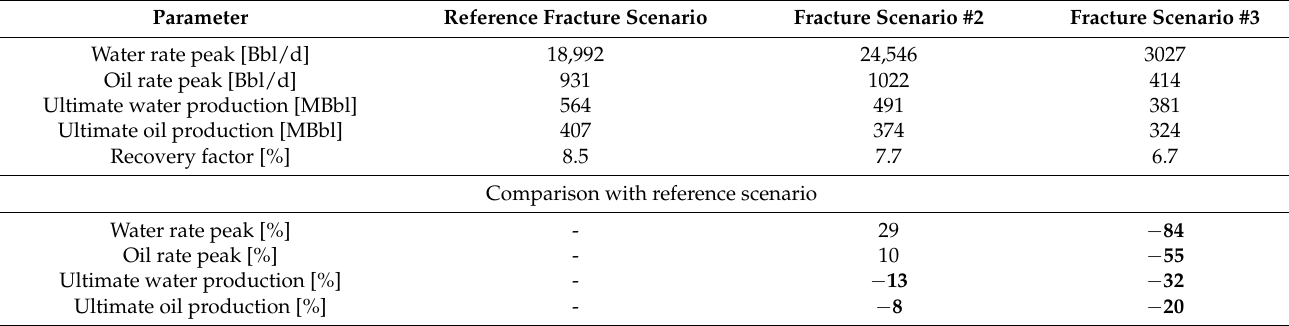
Table 4. Simulation case 2: production comparison after 15 years between fracture scenarios #2 and #3, and the reference fracture scenario #1. The reference scenario comprises 3 vertical hydraulic fractures (HF), fracture scenario #2 has 3 vertical hydraulic fractures and 8 orthogonal natural fractures (NF), and fracture scenario #3 has 3 vertical hydraulic fractures and 2 horizontal bedding planes (BP). In this case, vertical hydraulic fractures’ permeability is assumed to be the 2000 mD for scenarios #1 and #2. Scenario #3 has a vertical hydraulic fracture permeability of 200